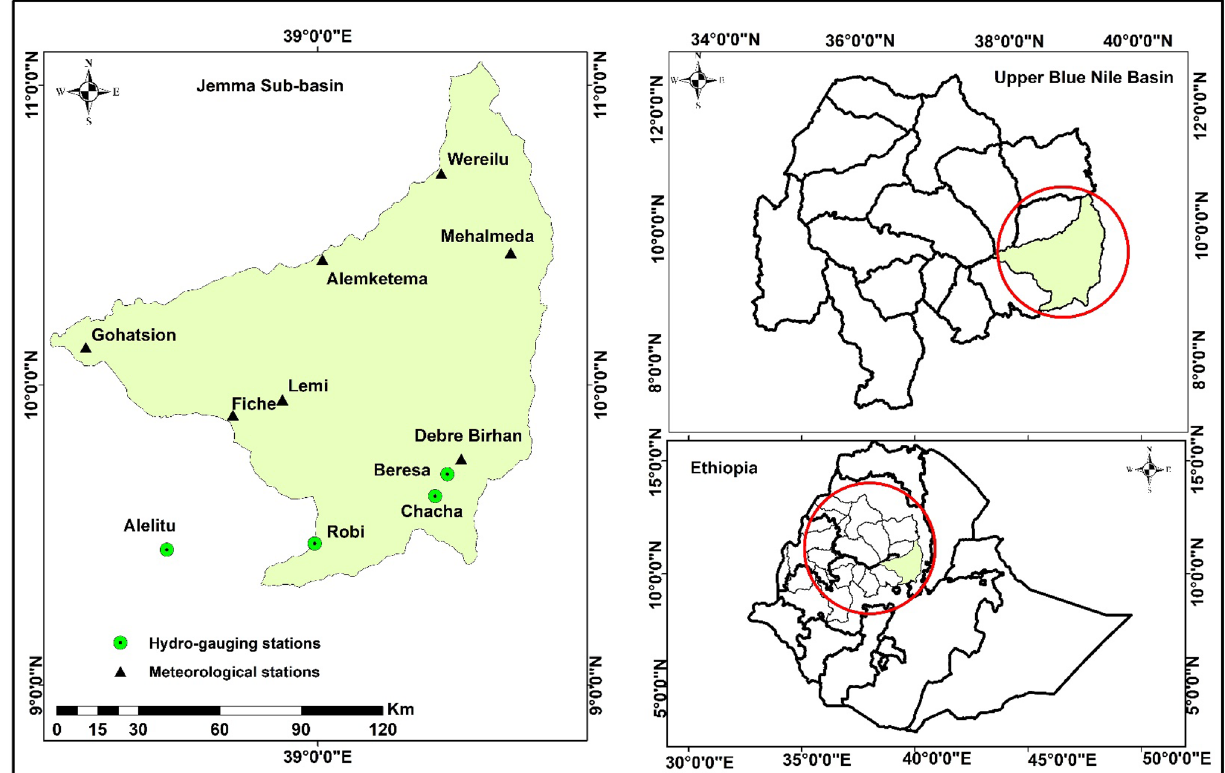
Fig. 1 Locations of the Jemma sub-basin and meteorological and hydro-gauging